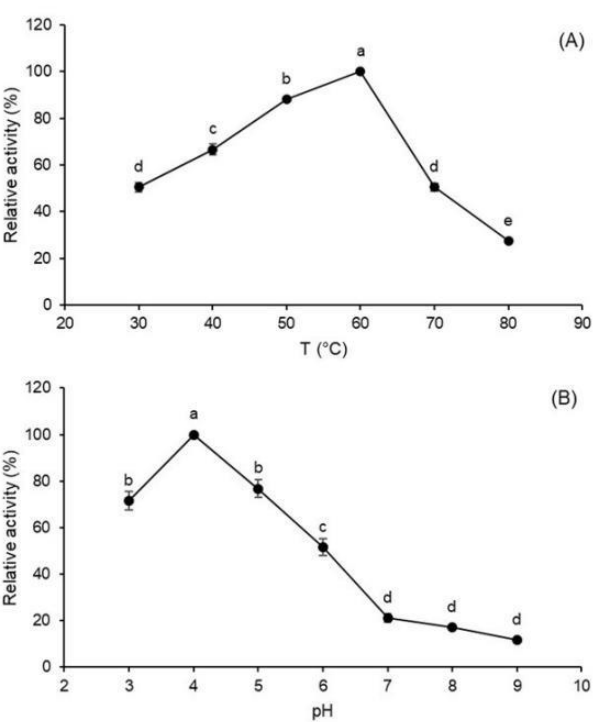
Figure 2. Effect of temperature ( A ) and pH ( B ) on the inulinase activity of Aspergillus terreus URM4658 inulinase produced by solid-state fermentation using wheat bran as a substrate. Different letters (a–e) indicate statistically significant differences ( p < 0.05). inulinase activity assays were also carried out on crude extracts from SSF in the presence of different metal ions, whose results are gathered in Table 6. The activity was not stimulated by any of the tested ions, but it was inhibited by Cu 2+ (35.41%) and almost completely lost using Hg 2+